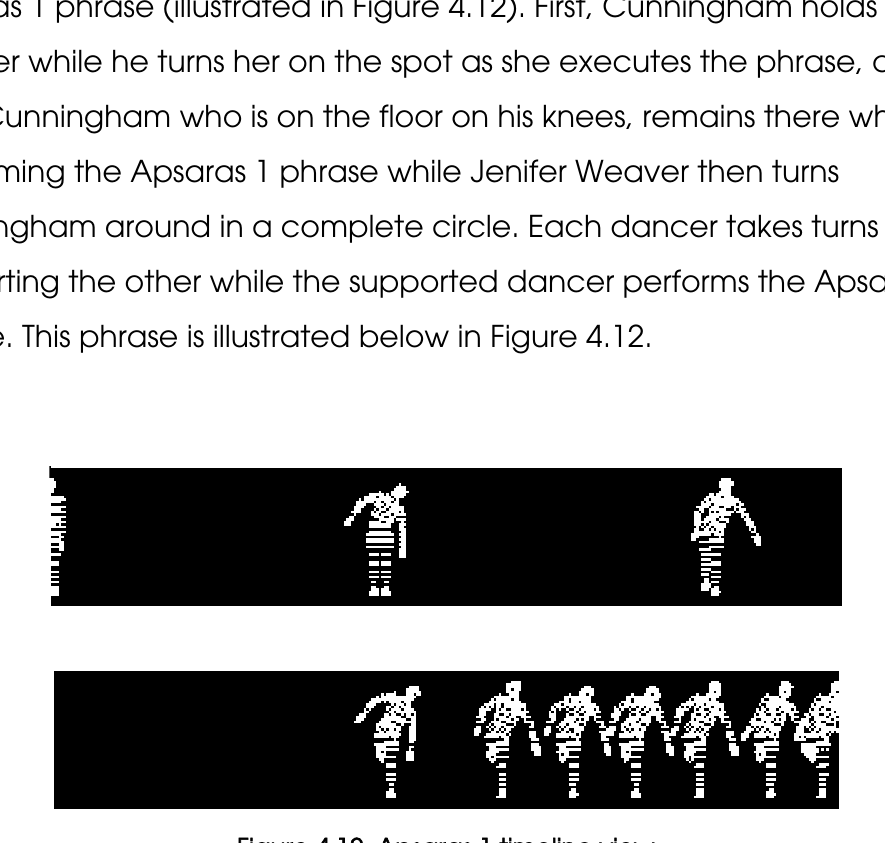
Figure 4.12. Apsaras 1 timeline